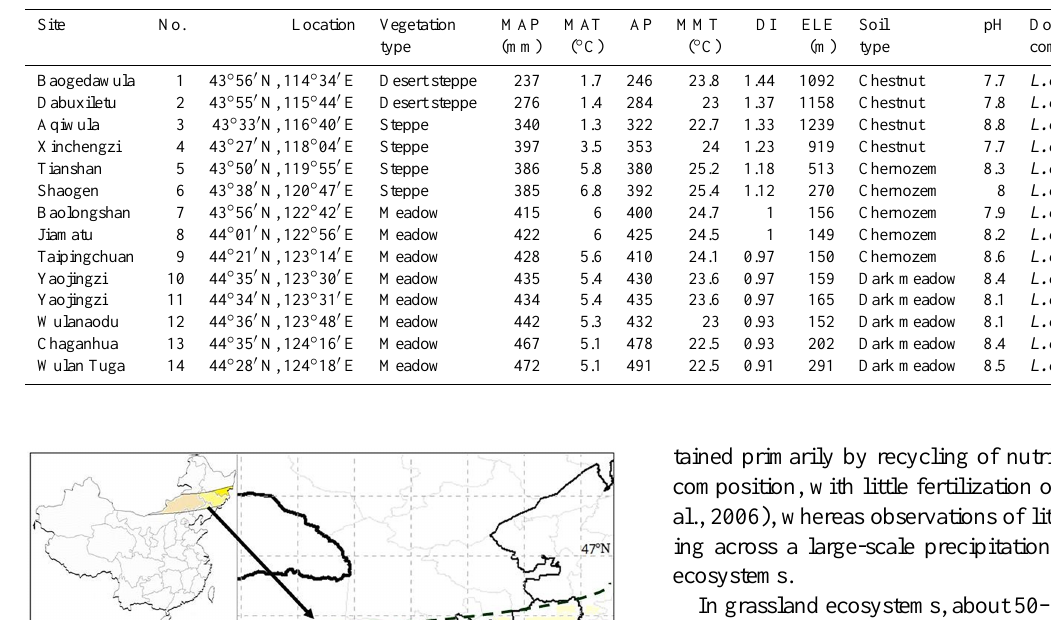
Table 1. Locations of the study site (1–14; see Fig. 1), vegetation type, climatic index, soil type, pH, dominant and companion species. MAP, mean annual precipitation; MAT, mean annual temperature; AP, annual precipitation in 2012; MMT, mean monthly temperature; DI, aridity index; ELE, elevation.